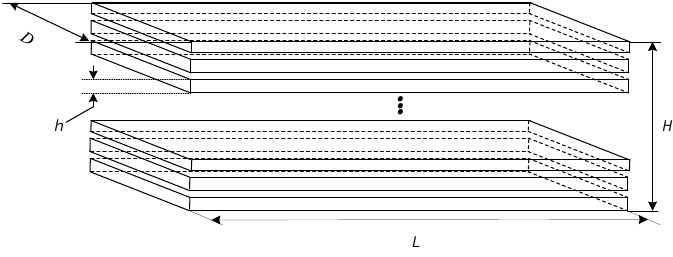
Figure 3. Schematic diagram of laminated magnetic core.